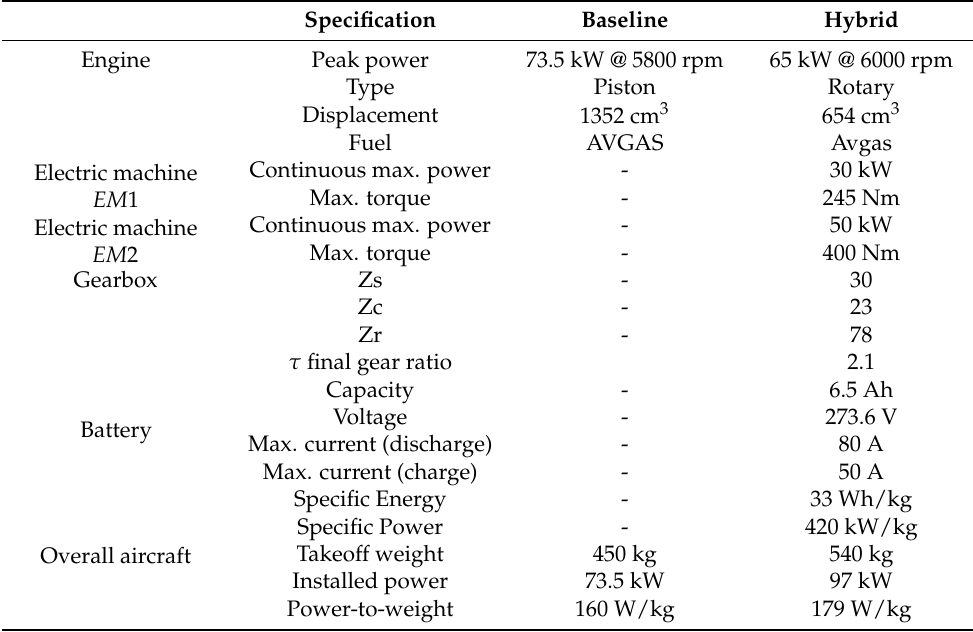
Figure 7. The hybrid electric powertrain. Table 3. Specification of the hybrid electric configuration compared with the baseline